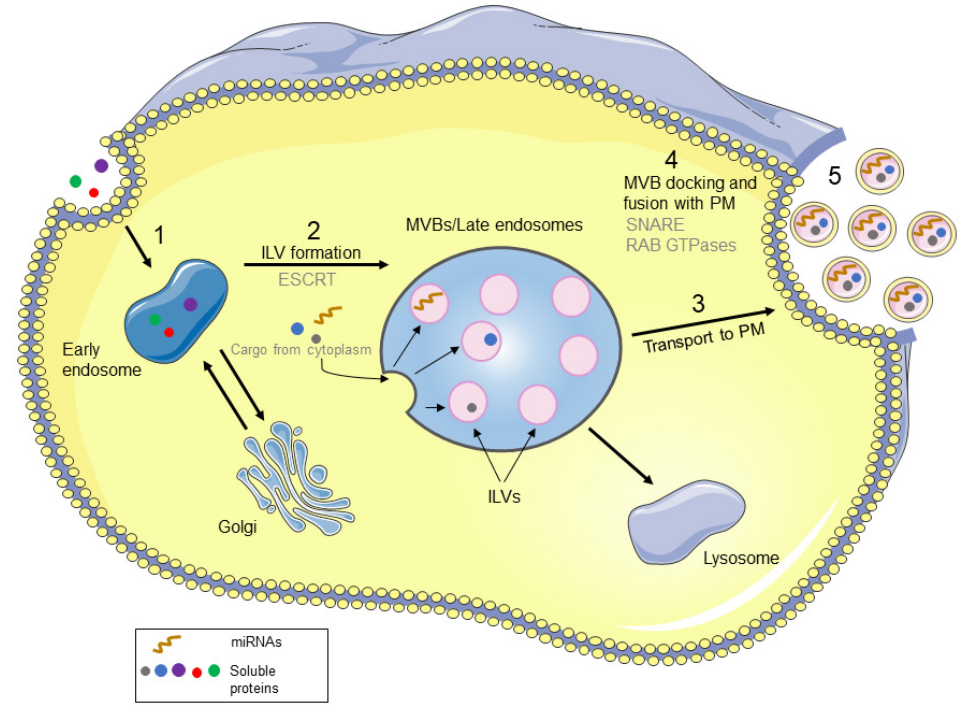
Figure 1. Biogenesis of exosomes. (1) Cargoes are internalized to form early endosomes. (2) Cytoplasmic compartments are sorted into ILVs to form MVBs. (3) MVBs containing exosome cargo are transported to the plasma membrane through the cytoskeleton and microtubule network. (4) MVBs are docked with the plasma membrane through SNARE and Rab GTPases. (5) ILVs are released as exosomes by exocytosis. ESCRT, endosomal sorting complex required for transport; MVBs, multivesicular bodies; ILVs, intraluminal vesicles; PM, Plasma membrane; SNARE, soluble NSF attachment protein receptors.